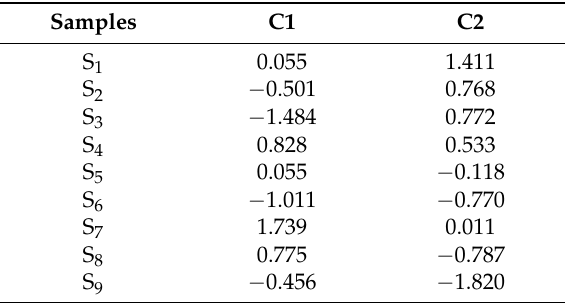
Table 5. The scores of two components C1 and C2.